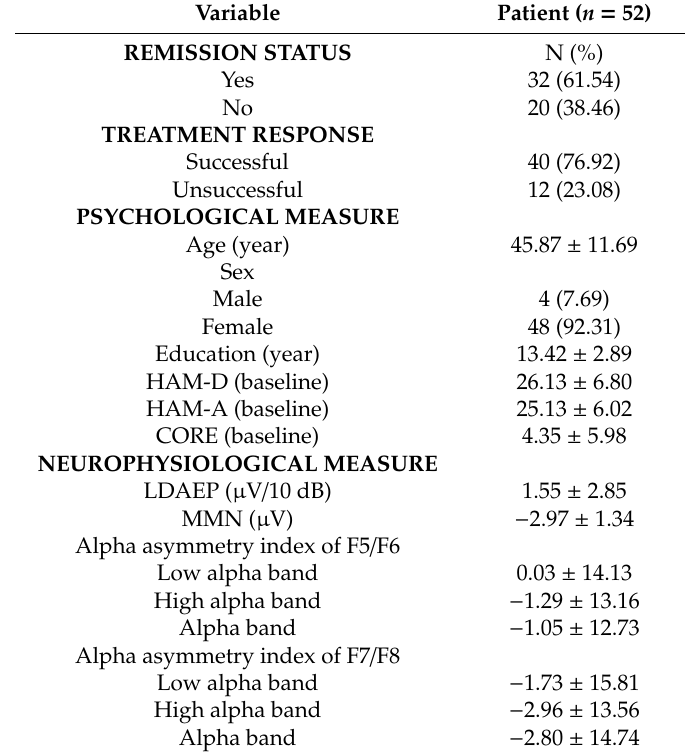
Table 1. Descriptive statistics of remission status, treatment response, psychological measure, and neurophysiological measure data of participants.